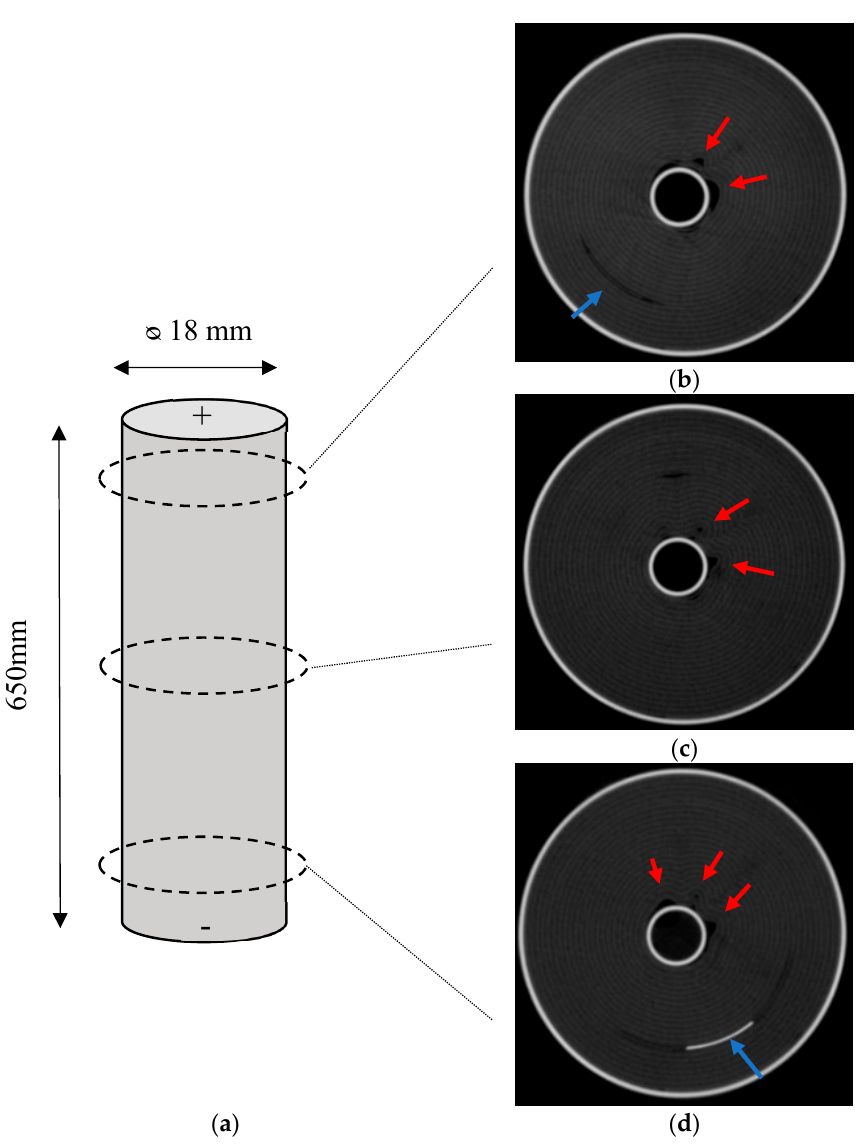
Figure 6. Axial scans of high rate cycled cell. ( a ) shows schematic of cell, ( b ) shows top, ( c ) shows middle and ( d ) shows bottom of cell. Red arrows show kinks and tabs are shown by blue arrows.